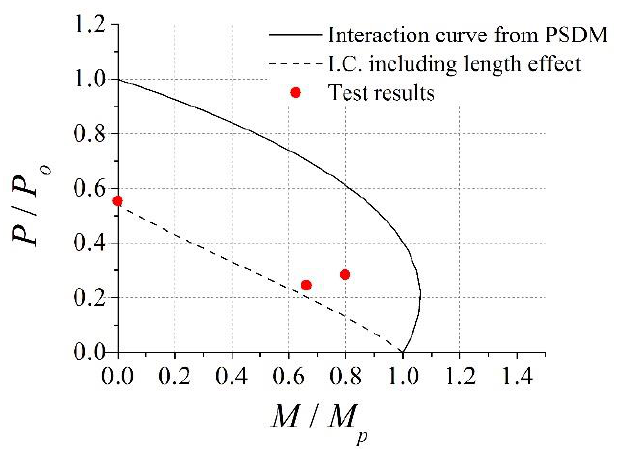
Figure 20. Comparison of the interaction curve from EC4 with the test results [L = 2500 mm].